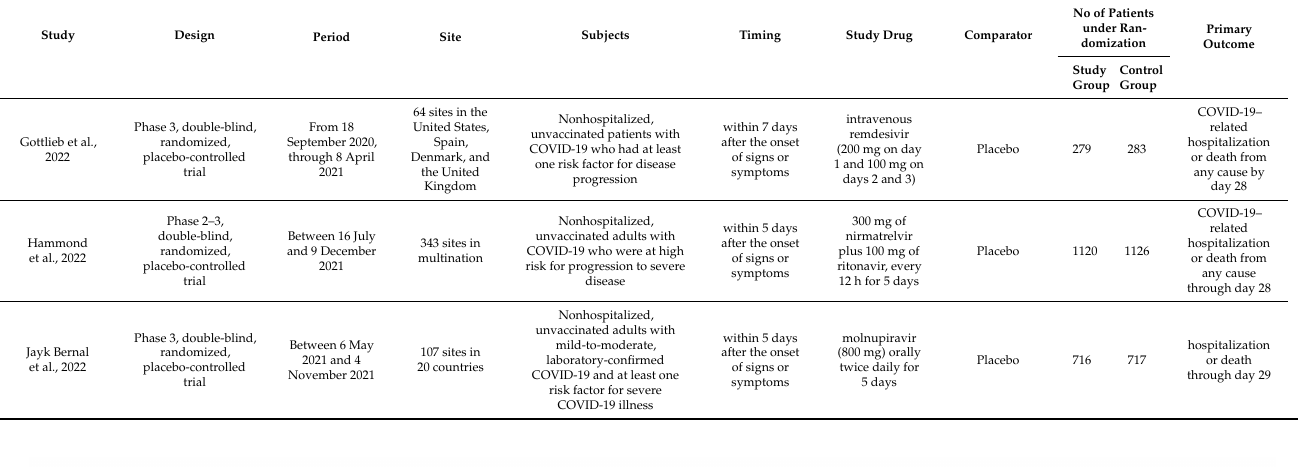
Table 1. Characteristics of included studies.